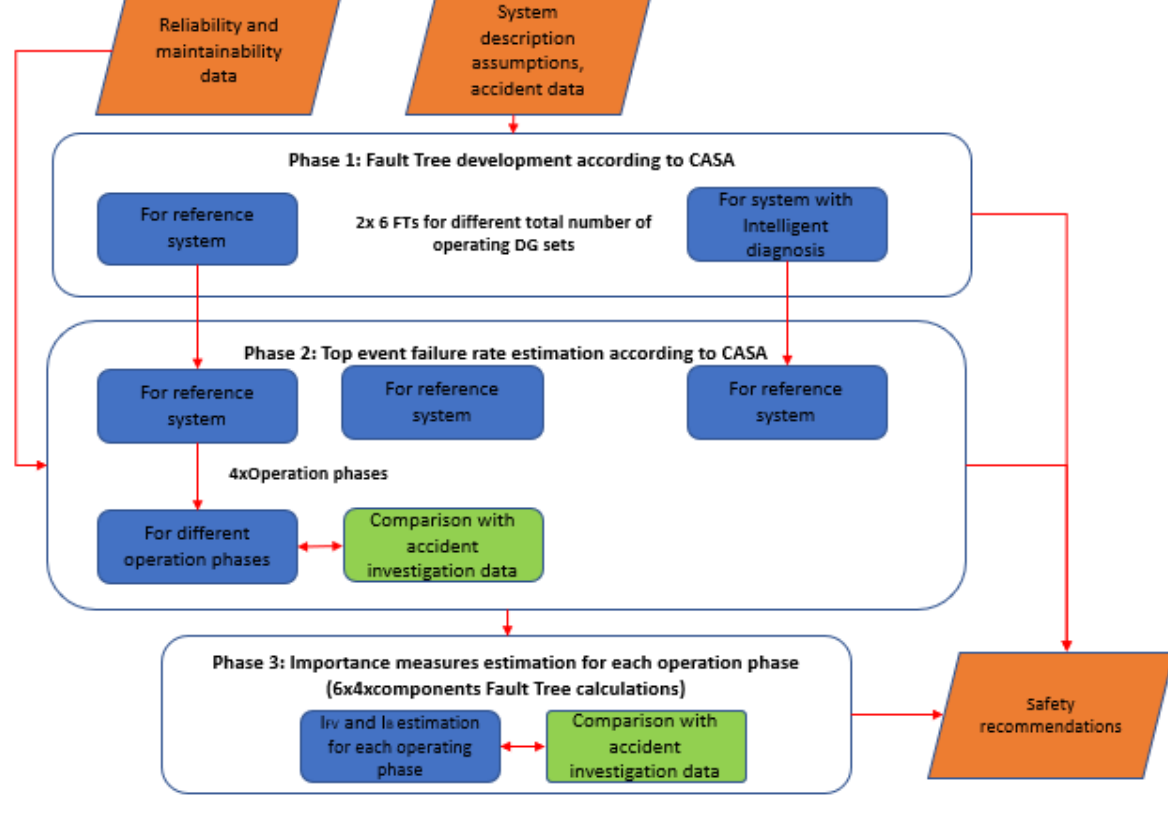
Figure 3. Methodology flowchart.